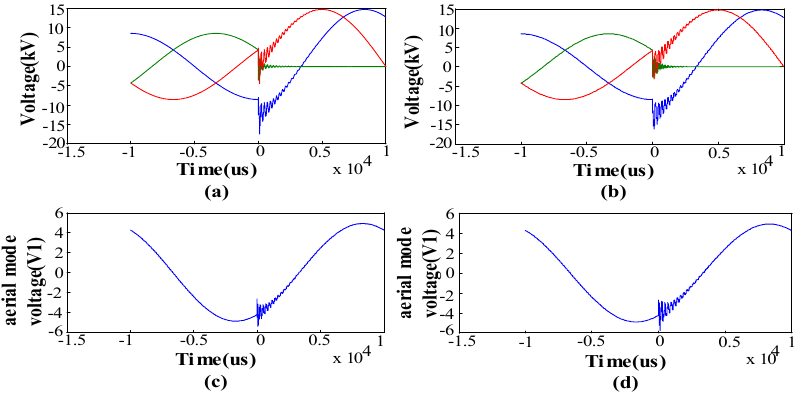
Figure 10. The voltage TWs and their aerial-mode components for a phase-to-ground fault on the branch. ( a ) The voltage TW measured at measurement unit 1; ( b ) The voltage TW measured at measurement unit 4; ( c ) The aerial-mode component of ( a ); ( d ) The aerial-mode component of ( b ).